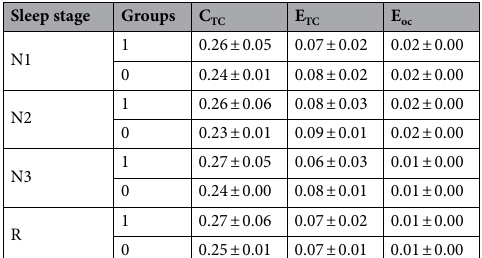
Table 4. Significantly different microstate parameters C TC , E TC , Eoc of 5 microstates in OSA_OH (marked 1 in the table) and OSA_withoutOH (marked 0 in the table) patients.